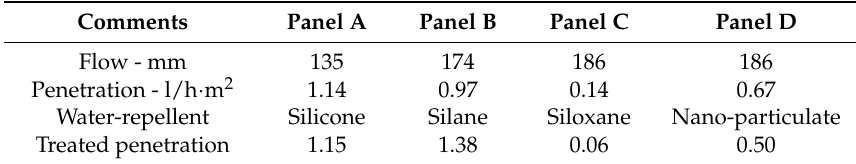
Table 6. Water penetration towards the end of the testing.